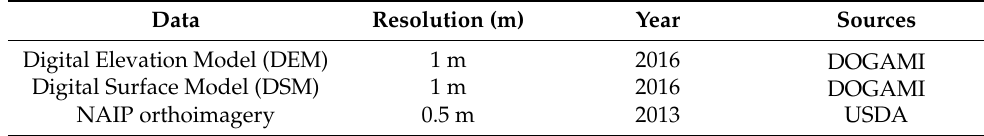
Table 2. Raster data